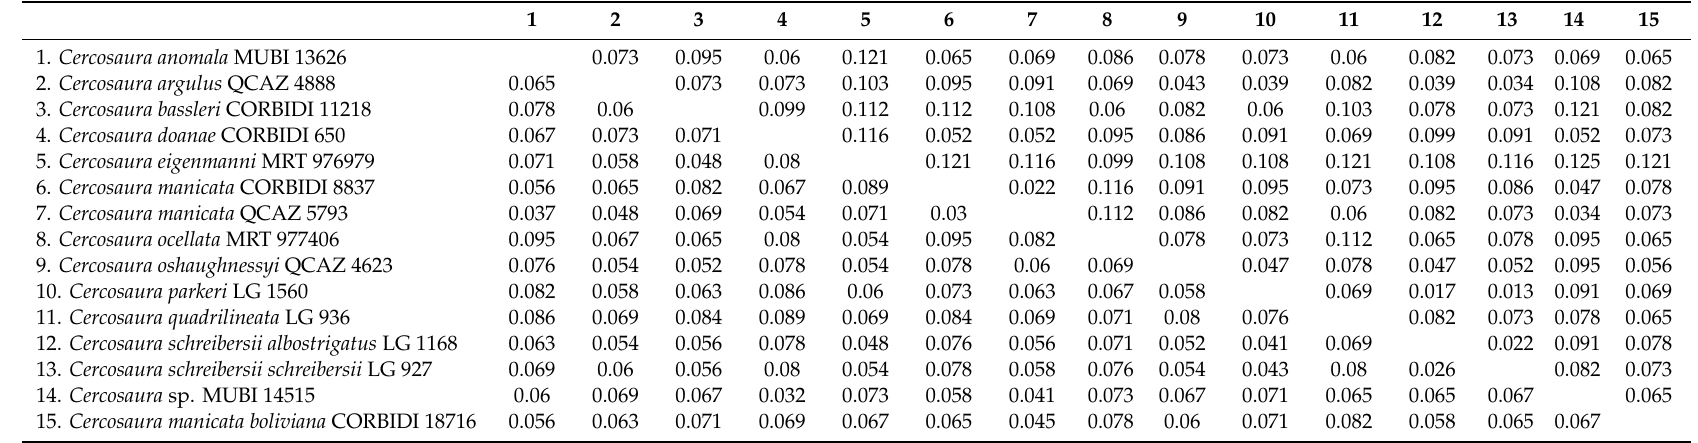
Table 3. Uncorrected p-distances for 12S (top) and 16S (bottom) genes between Cercosaura anomala , Cercosaura sp., and “ C. manicata boliviana” and other cercosaurine species.